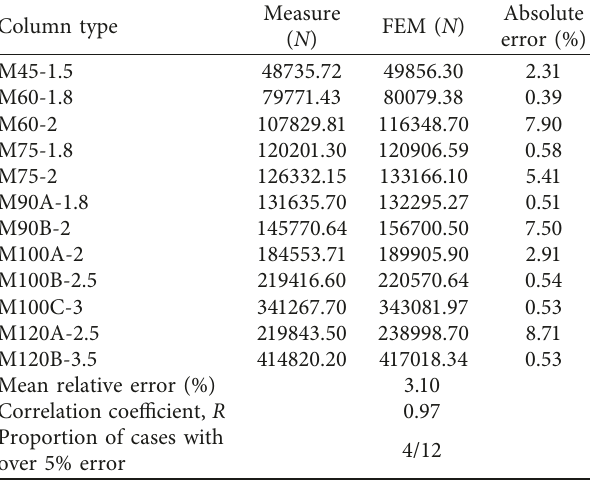
Table 2: Comparison among the real measured values and finite element numerical